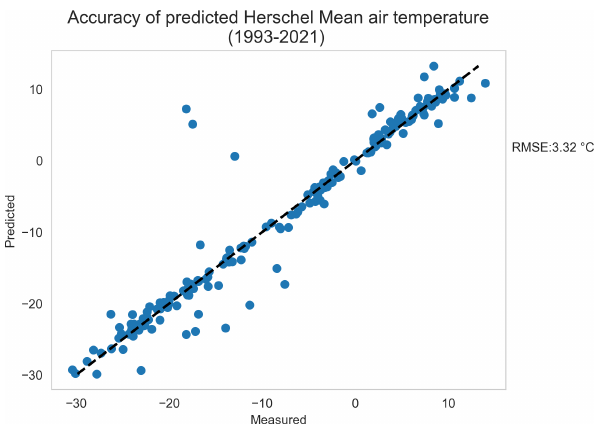
Figure A1. Result from linear regression between air temperature measured on Herschel Island and predicted value using the Burn and Zhang (2009) equation.